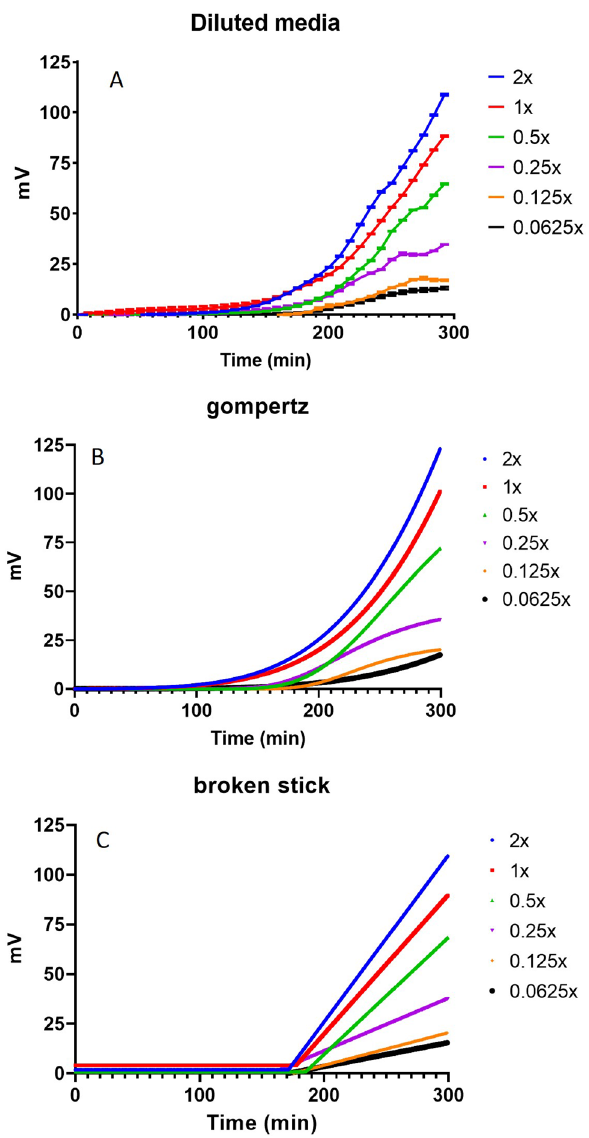
Figure 4. E. coli ATCC 25922 was diluted to give starting inocula of between 10 1 and 10 7 cfu mL −1 and cultured in Mueller Hinton cation adjusted broth at 2×–0.0625× the standard concentration. These cultures were incubated for up to 5 h at 37 °C. The points represent the mean of three independent biological observations of output mV. In ( A ), mean data points are linked, and in ( B ), data are fitted to a modified Gompertz equations (solid line) and ( C ). Data are fitted to a Broken Stick equations (hatched line).